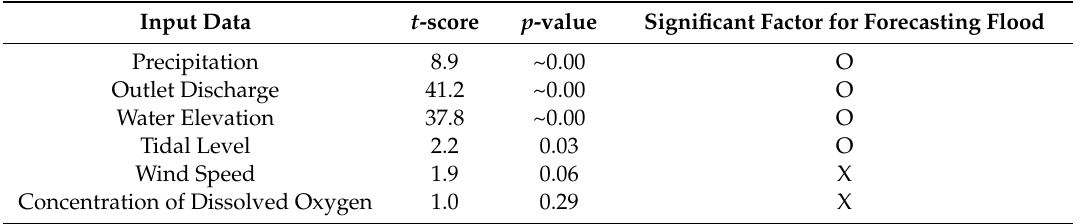
Figure 3. p -value derivation process. Table 3. t -test analysis for input data.